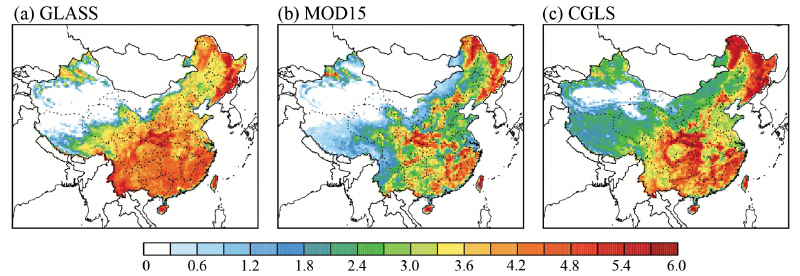
Figure 2. Distribution of LAIv from different satellite datasets in the summer of 2016. Table 1. Simulation schemes with different land cover (LC) and leaf area index